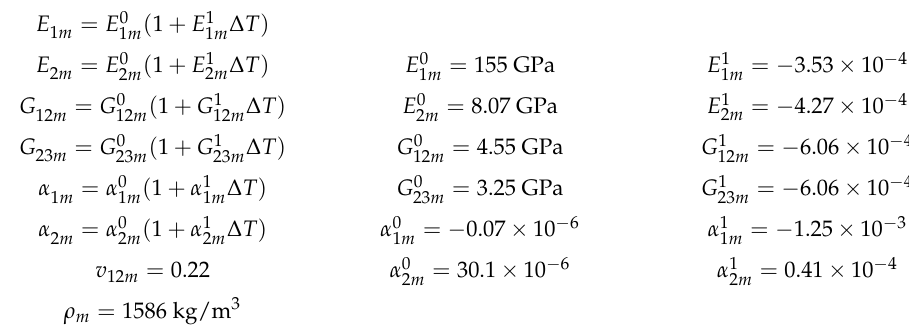
Table 2. Thermomechanical properties of the